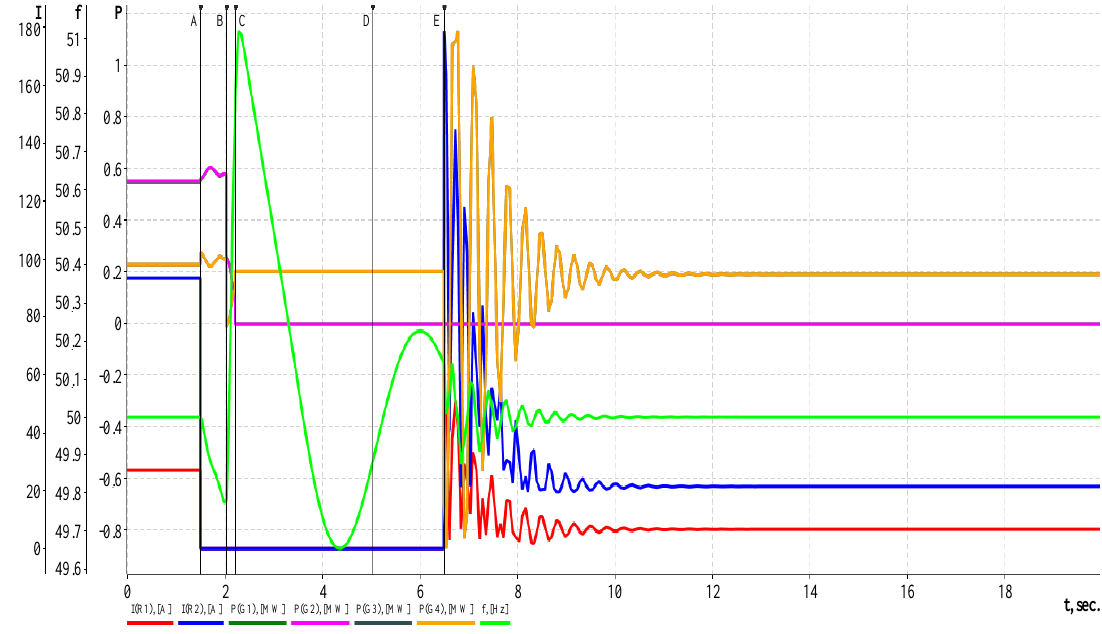
Figure 9. The microgrid transient response with 20% of the maximum load. Energies 2020 , 13 , x FOR PEER REVIEW